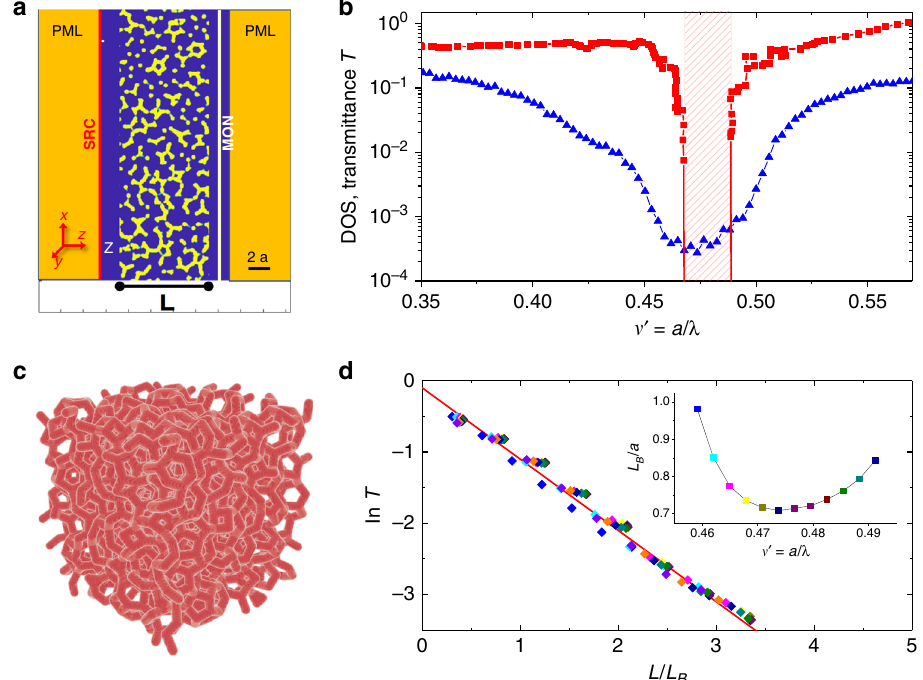
Fig. 1 Numerical simulations of optical transport properties. a Cross section of a three-dimensional FDTD (MEEP) simulation box containing a hyperuniform silicon ( n = 3.6) network structure, thickness L = 6 a . A light wave, linearly polarized along the x -axis, is launched on the leftside and propagates along the z-axis. The photonic network structure is terminated with perfectly matched layers (PML) at both sides of the box along the propagation axis. PMLs act as absorbers. The source (SRC) and detector (MON) are placed at a distance approximately ~ a from the sample, which is held in vacuum. Periodic boundary conditions are applied along x and y directions. b Triangles: transmittance spectrum T ( a / λ ) for a slab of thickness L = 18 a for a fi lling fraction ϕ = 0.28. The optical transport data is compared to numerical calculations of the density of states (DOS) (squares). The bandgap-center ¼ a = λ ¼ 0 : 478 and the width Δν is indicated by the shaded area. c Three-dimensional rendering of a hyperuniform network structure, frequency is ν 0 Gap Gap edge length 6 a and fi lling fraction ϕ = 0.28. The size of the structure used in the simulation is 18 a × 18 a × L with L ≤ 18 a , which is repeated periodically in ( x , y ) direction to construct the slab geometry. d In the gap the transmittance decays exponentially and lnT collapses on a master curve when plotted in ¼ 0 : 478, see also Supplementary Fig. reduced units L / L B . L B ≤ a denotes the Bragg length and it is found to be smallest near the gap-center frequency ν 0 Gap